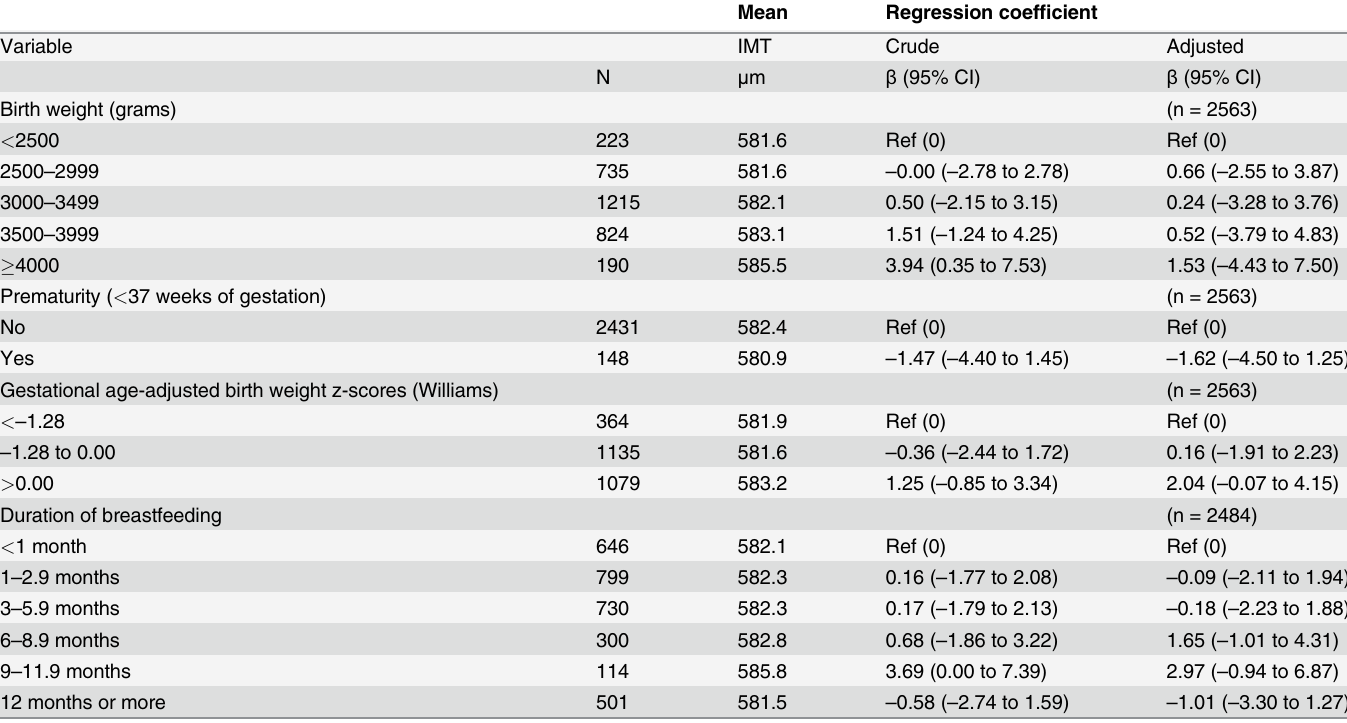
Table 2. Crude and adjusted analysis of the association of birth weight and breastfeeding with carotid intima-media thickness in the cohort participants at the follow-up in